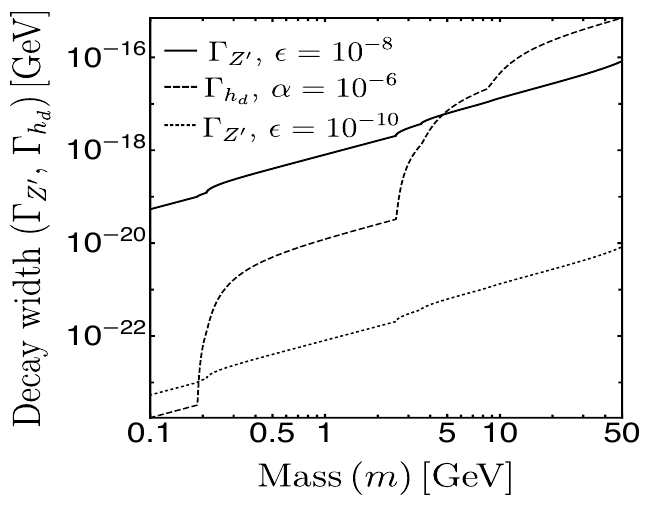
Figure 10 . Decay width of h d for α = 10 − 6 (dashed line) and Z 0 for (cid:15) = 10 − 8 (solid line), 10 − 10 (dotted line) as a function of mass ( m